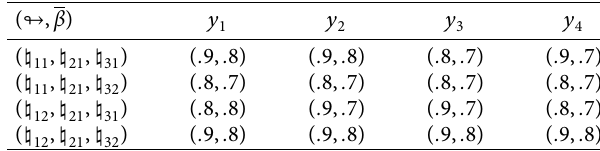
Table 4: q-ROFHS